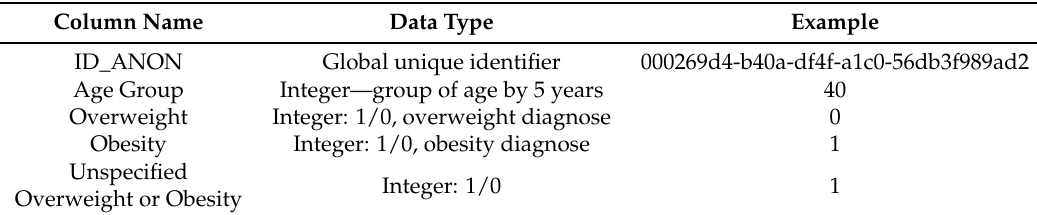
Table 3. Patients Anonymize table